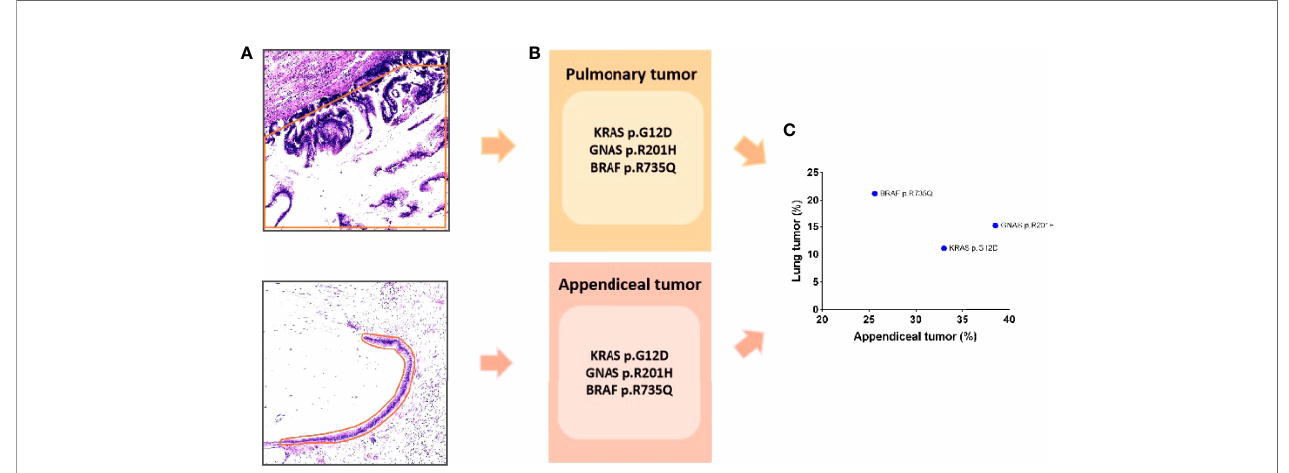
FIGURE 2 | (A) The tumor was accurately sampled from a section under the microscope (the orange line indicates the sampling range). (B) The sequencing results show that both tumors had the same mutation: KRAS (p.G12D), GNAS (p.R201H), and BRAF (p.R735Q). (C) The variant allele frequency is shown in scatter